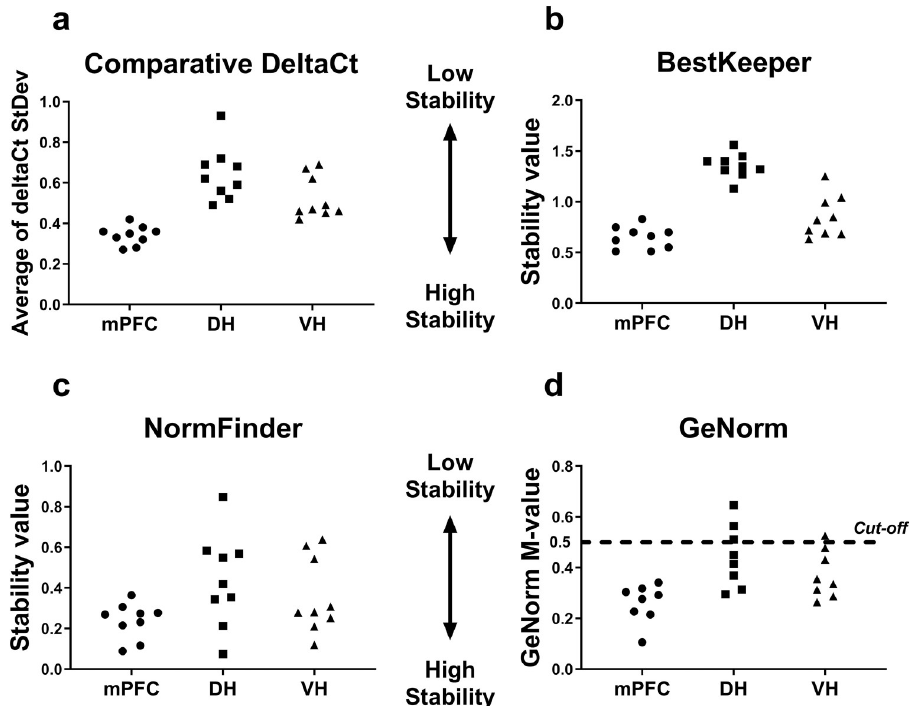
Fig 2. Reference gene stability values of each housekeeping gene obtained by four methods in three different brain regions of rats fed with MCT. MCT (2 ml/kg body weight) were given as a supplement to standard feed to adult (9 m. o., BW = 444 ± 69 g) animals by oral gavage daily for 4 weeks, while the control rats received equivolume water. Expression stability values of nine housekeeping genes ( Actb , Gapdh , B2m , Rpl13a , Sdha , Ppia , Hprt1 , Pgk1 , Ywhaz , each represented by a dot per each brain structure) in the medial prefrontal cortex (mPFC, circular dots), dorsal (DH, square dots) and ventral (VH, triangular dots) hippocampal areas were analyzed using (a) comparative Delta-Ct, (b) BestKeeper, (c) NormFinder, and (d) GeNorm methods. For GeNorm (D), values above 0.5 cut-off M-value indicate unstable genes inappropriate for RT-qPCR data normalization. Only eight M-values are presented because the GeNorm method calculates a single M-value for the pair of the most stable